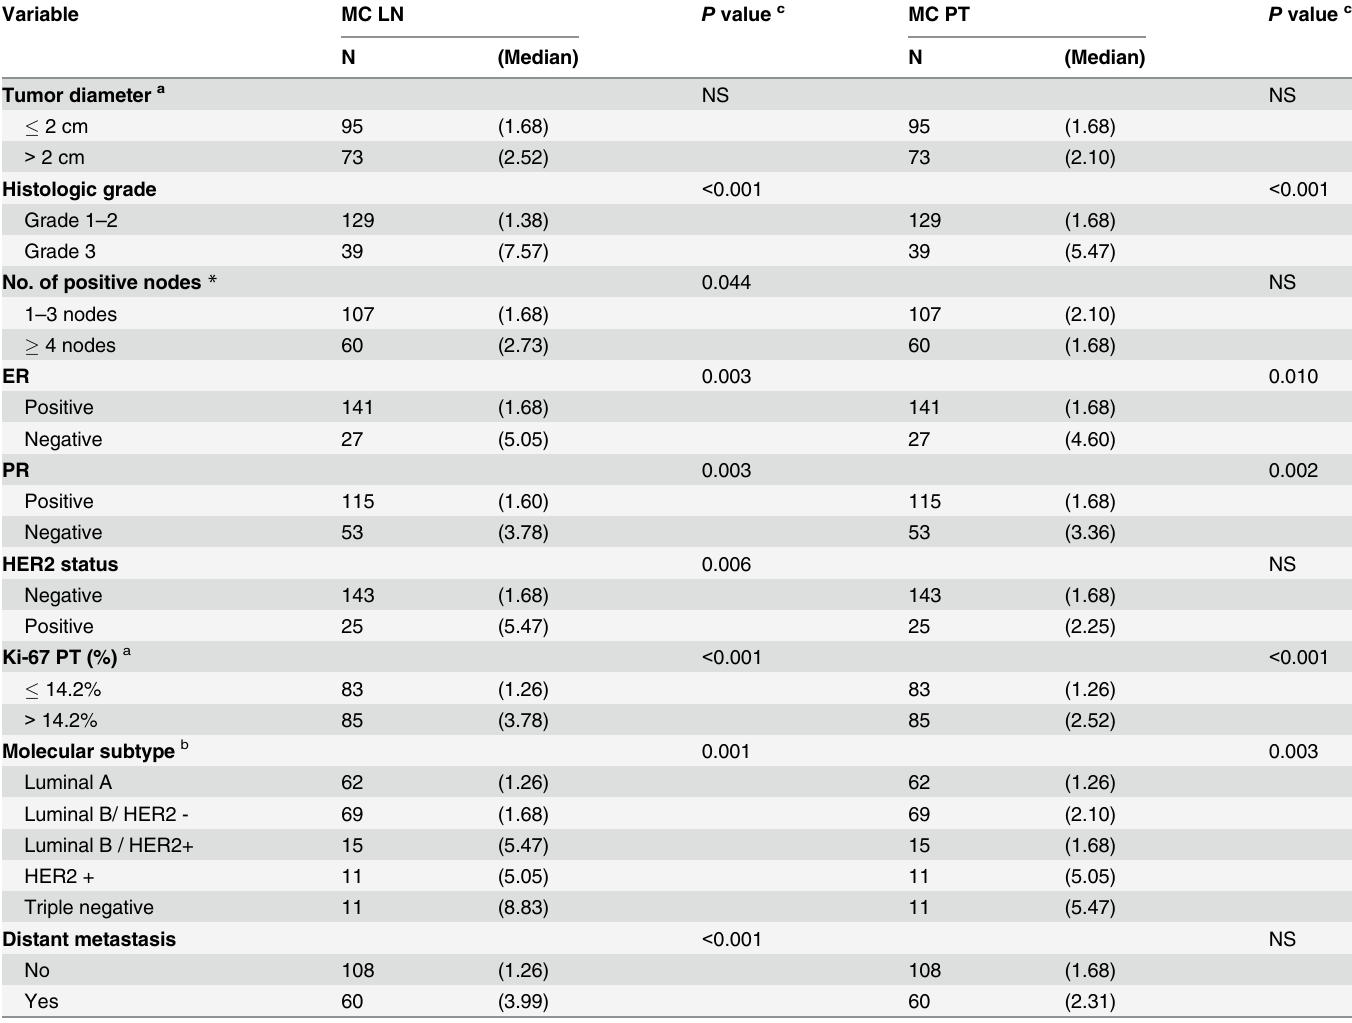
Table 2. Mitotic count (MC) and clinico-pathologic features of the primary tumors ( n =